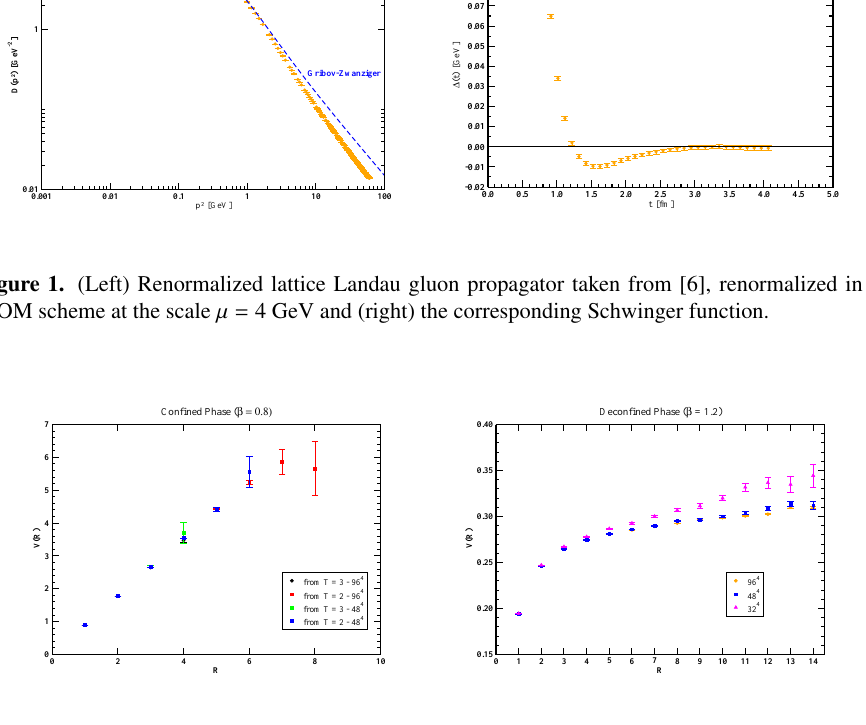
Figure 2. The static potential V ( R ) for compact QED in the confined phase (left) and deconfined phase (right). Details of the calculation can be found in